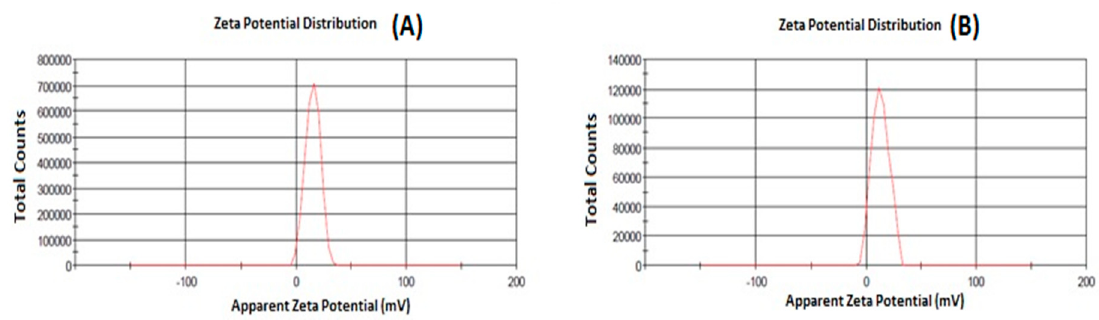
Figure 2. Represent zeta potential of blank NPs ( A ) and NAR NPs ( B ) measured by zetasizer.